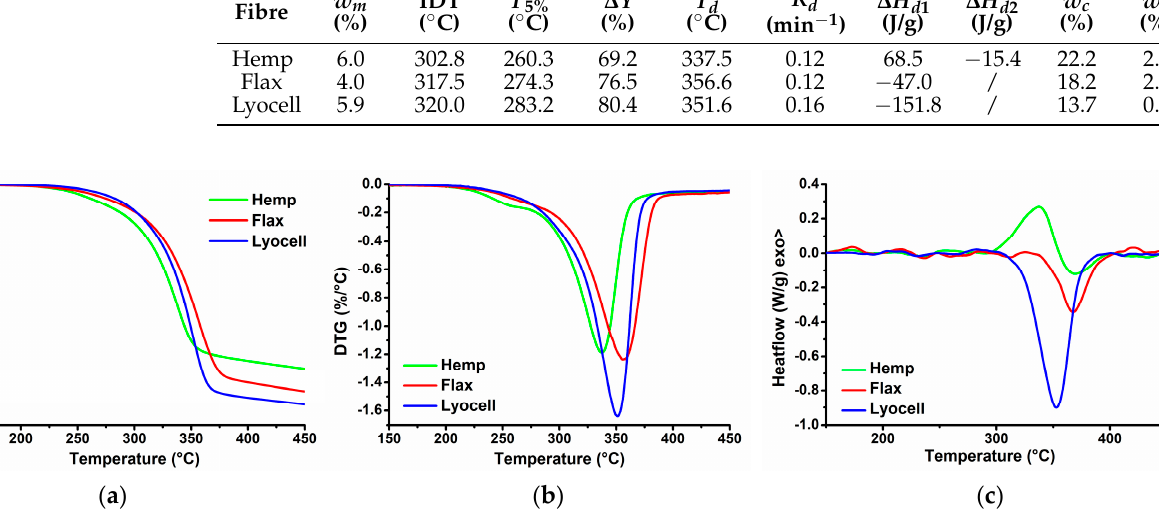
Figure 1. Non ‐ isothermal TGA/DSC thermograms of hemp, flax and Lyocell fibres in the main decomposition region: ( a ) TGA thermograms; ( b ) DTG thermograms; ( c ) DSC thermograms.